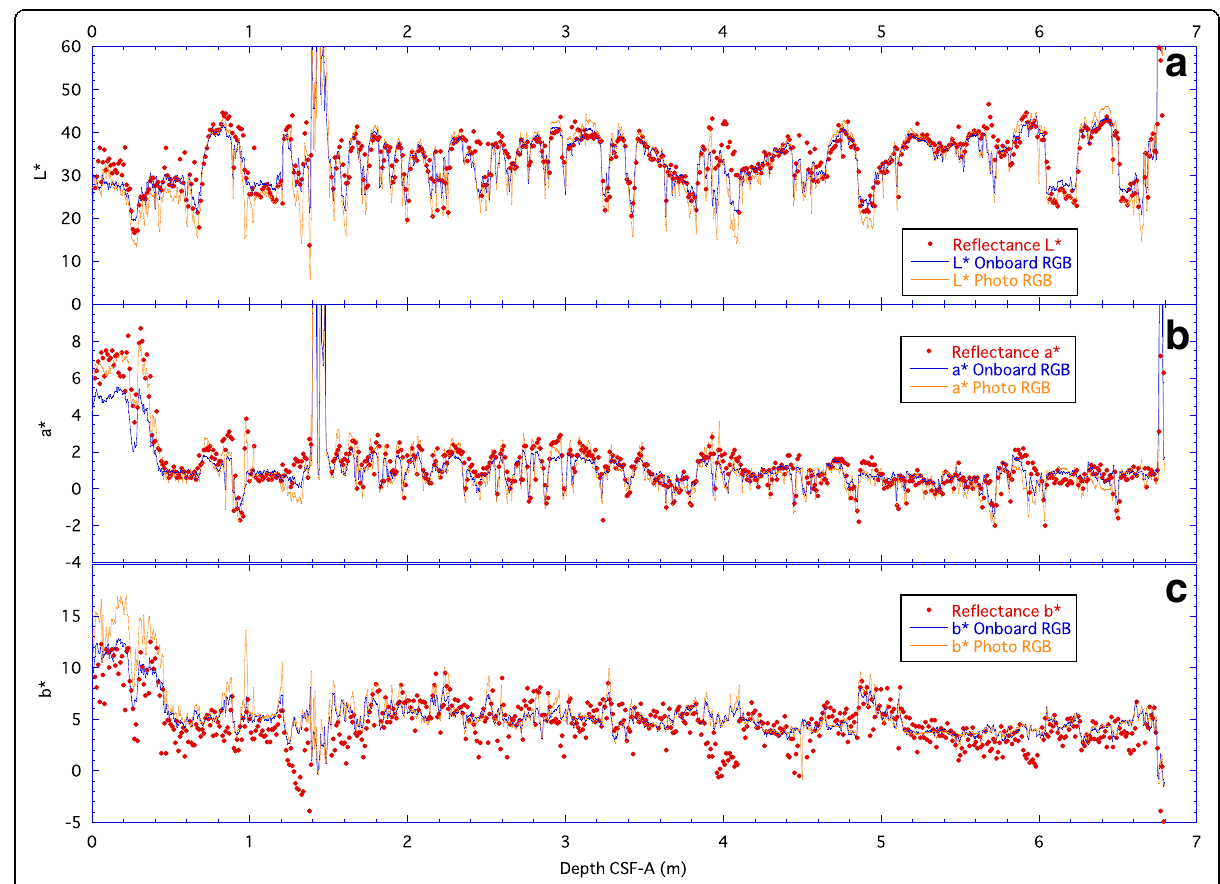
Fig. 4 Comparison between L* ( a ), a* ( b ), and b* ( c ) measured onboard (red dots) and those calculated from shipboard RGB (blue line) and photo RGB (orange line) in IODP Exp. 346 Site U1424A